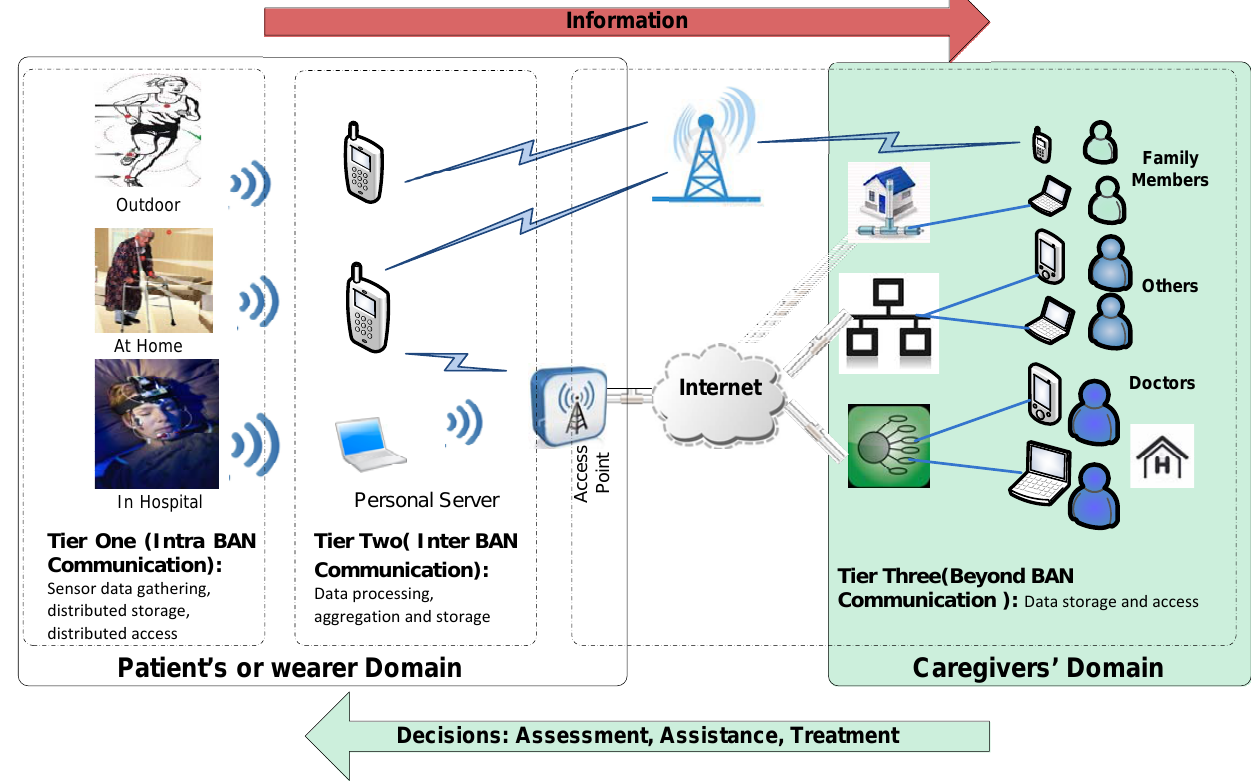
Figure 1. Structural design of wearable health monitoring system